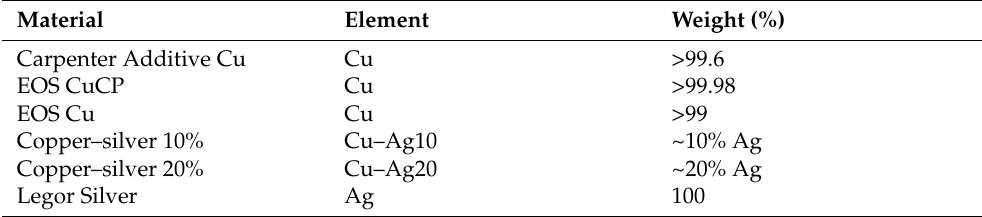
Table 1. Material suppliers and element weight (%) of Cu and Ag